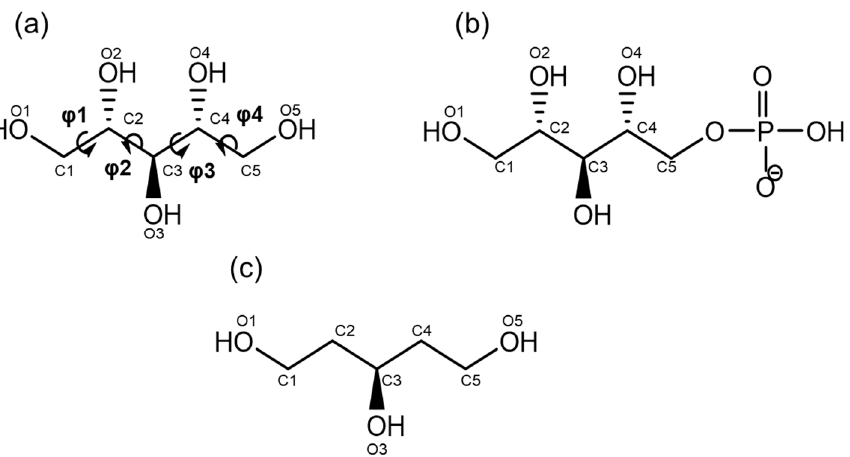
Figure 1. Chemical structures of the compounds examined in this study. ( a ) Ribitol, ( b ) ribitol phosphate ( D -ribitol 5-phosphate is analyzed in this study, which is the form found in nature), and ( c ) 1,3,5-pentanol (reference compound). Carbon and oxygen numbering is indicated in the figure. The main-chain dihedral angles are defined as ϕ 1 (O1–C1–C2–C3), ϕ 2 (C1–C2–C3–C4), ϕ 3 (C2–C3–C4–C5), and ϕ 4 (C3–C4–C5–O5) throughout this